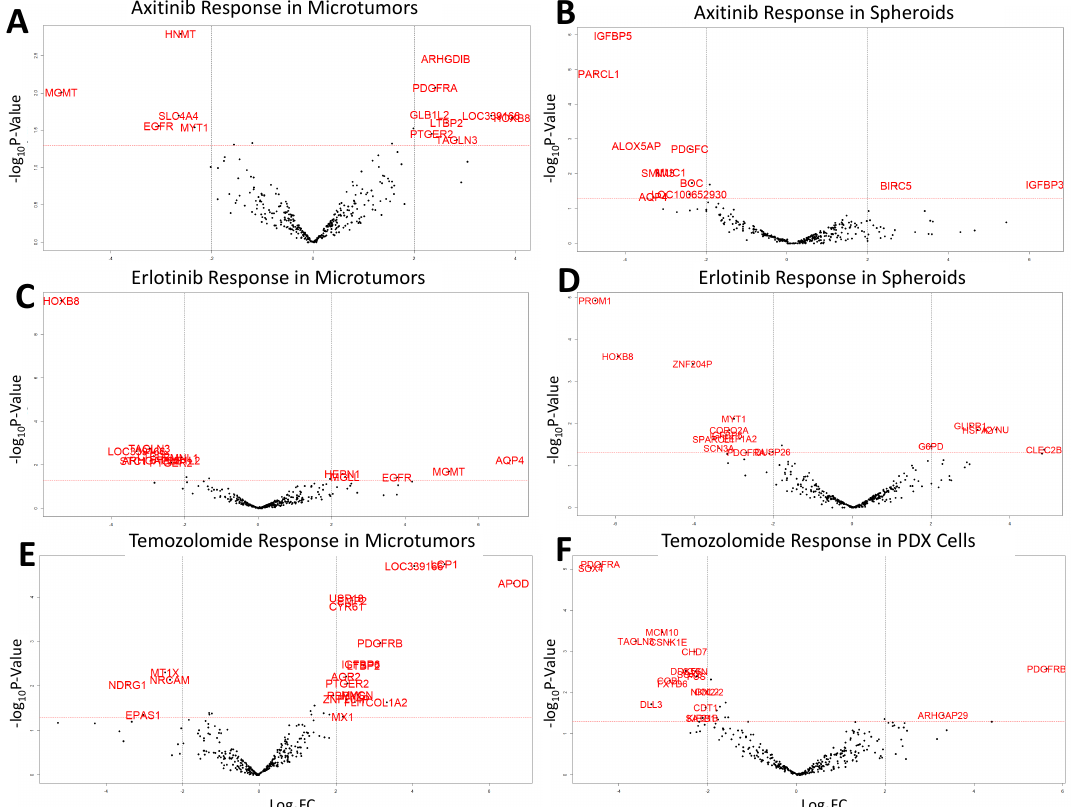
Figure 4. Drug screening di ff erential expression results for Axitinib, Erlotinib, and Temozolomide: ( A ) Di ff erential expression of genes related to Axitinib response in microtumors; ( B ) Di ff erential expression of genes related to Axitinib response in spheroids ( n = 6); ( C ) Di ff erential expression of genes related to Erlotinib response in microtumors ( n = 12); ( D ) Di ff erential expression of genes related to Erlotinib response in spheroids ( n = 6); ( E ) Di ff erential expression of genes related to Temozolomide response in microtumors ( n = 12); ( F ) Di ff erential expression of genes related to Temozolomide response in orthotopic PDX cells ( n = 10). Significance of red labeled genes determined by: p ≤ 0.05 and − 2 ≥ log 2 Fold Change ≥